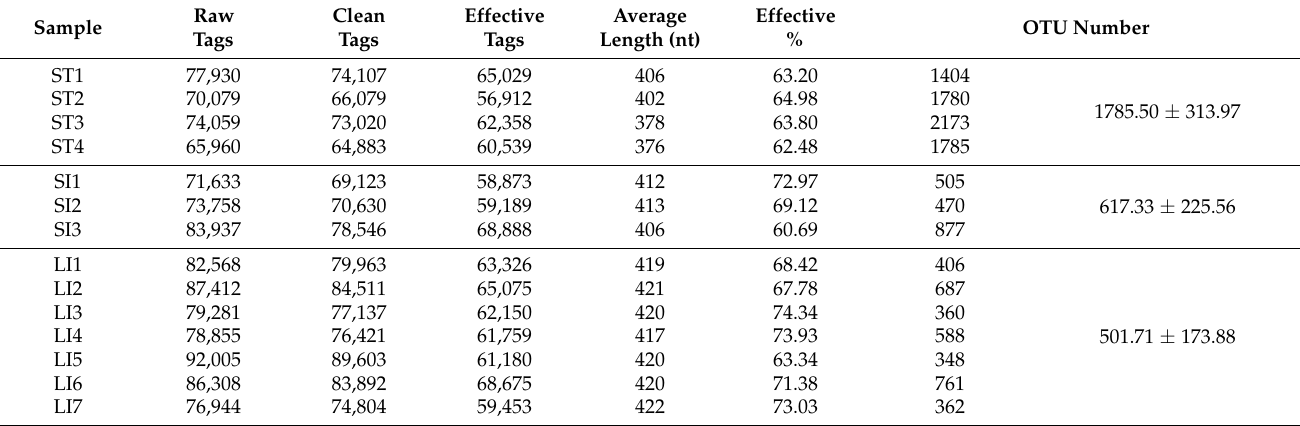
Table 1. Statistics of the sequencing data preprocessing and quality control.